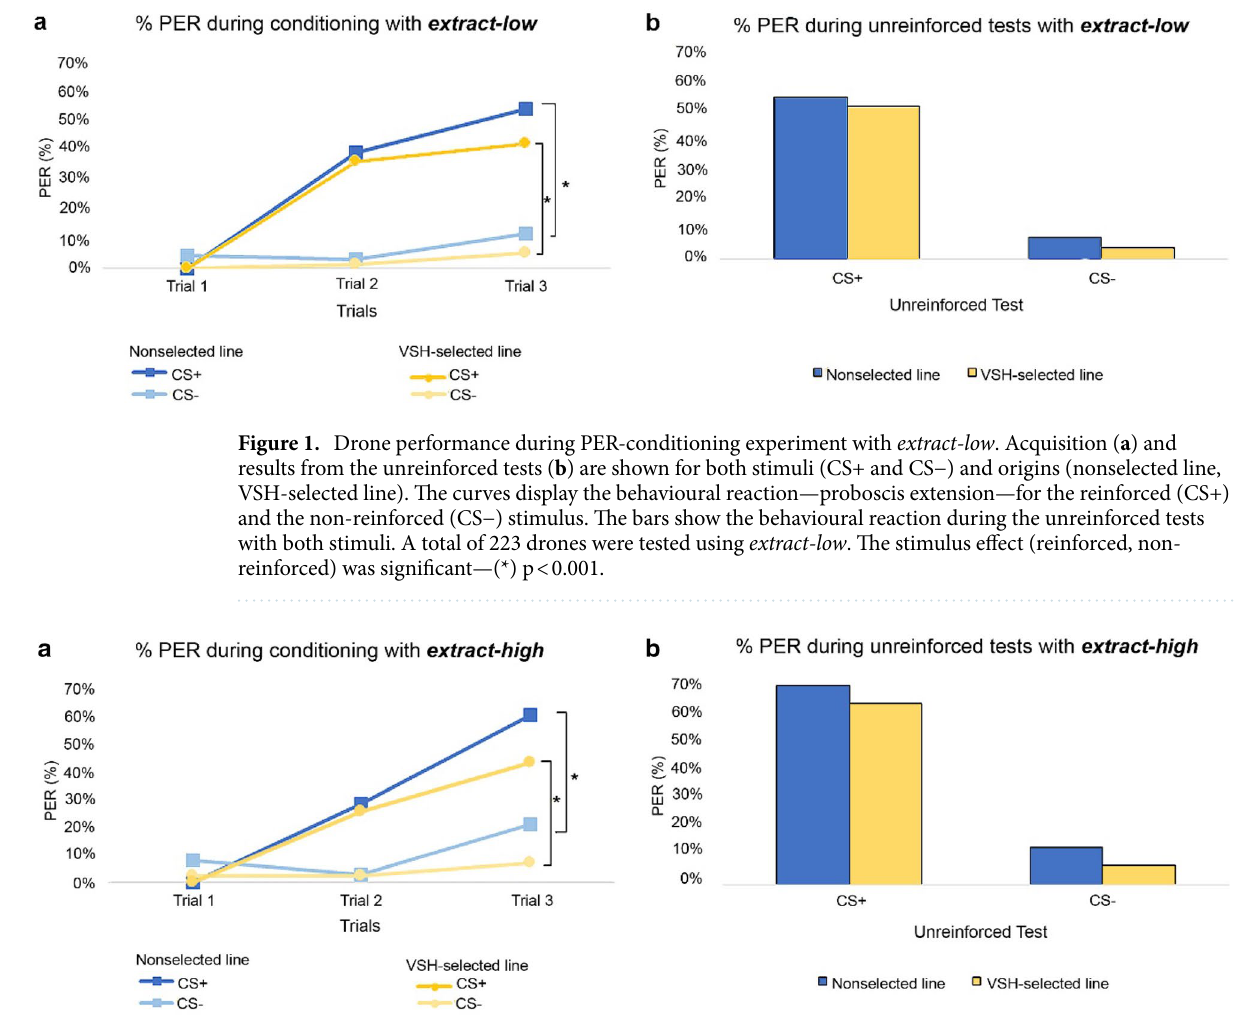
the conditioning and the drone’s mother had no significant effect on the conditioning results for either extract- high or extract - low . Mating design. Depending on the conditioning results, the drones were divided into two groups—“ Varroa - parasitised-brood-odour sensitive” ( SenD +) and “ Varroa -parasitised-brood-odour insensitive” ( SenD− ). "Sensi- tive" drones responded to the CS+ but not the CS− during the last two trials and during the unrewarded tests with extract-low —Trials: CS+, CS−, CS−, CS+, CS+, CS−; Unrewarded test: CS+, CS−. The "insensitive" drones responded to the US throughout the experiment with extract-high but showed no positive responses to the CS+ during the last two trials, and the unrewarded tests indicated a negative conditioning outcome. Queens from both a VSH-selected line and a nonselected line were one-drone inseminated with sperm from the “sensitive” or “insensitive” drones. Four groups were created during the one-drone insemination depending on the queen’s affiliation with the VSH-selected line ( SelQ ) or nonselected line ( ConQ ) 56 and the drone’s olfactory sensitivity towards the Varroa -parasitised-brood odour. The groups were created without regards to the genetic origin of the drones. Because drones from both origins were tested during the experiment, each group consisted of queens inseminated with sperm from drones from both lines (Suppl. Table 1).